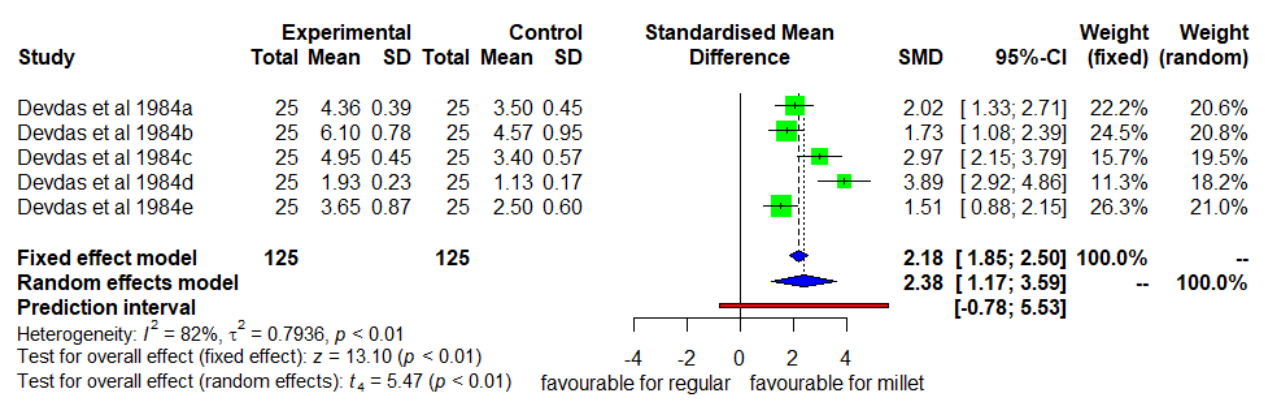
Figure 4. Effect of a consuming finger millet-based diet on mean change in MUAC compared to a regular rice-based diet.